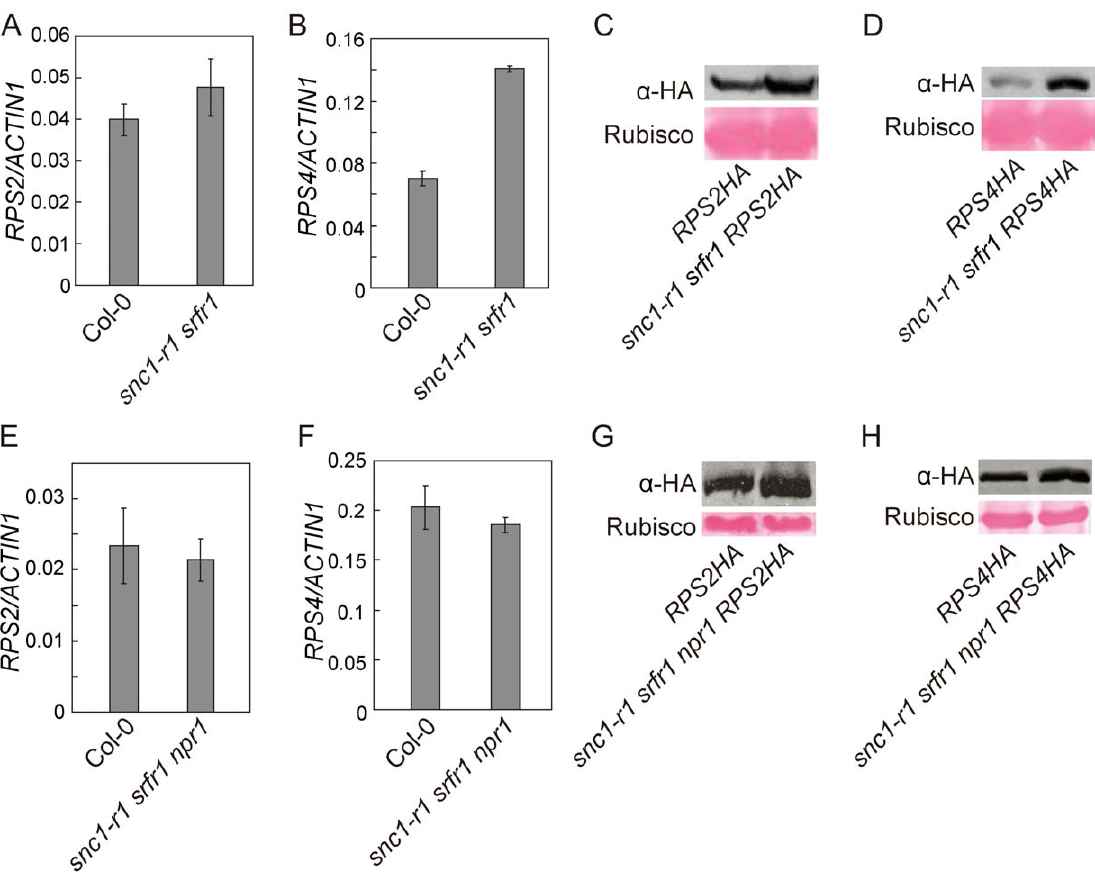
Figure 7. Analysis of the transcript levels of RPS2 and RPS4 and the accumulation of RPS2-HA and RPS4-HA proteins in snc1-r1srfr1-3 and snc1-r1srfr1-3npr1-1 . (A–B) Real-time RT-PCR analysis of RPS2 (A) and RPS4 (B) expression in wild type (Col-0) and snc1-r1 srfr1-3 . Error bars represent standard deviation from three measurements. (C) Western blot analysis of RPS2-HA protein levels in total protein extracts of RPS2-HA and snc1-r1 srfr1-3 RPS2-HA lines. (D) Western blot analysis of RPS4-HA protein levels in total protein extracts of RPS4-HA and snc1-r1 srfr1-3 RPS4-HA lines. (E–F) Real-time RT-PCR analysis of RPS2 (E) and RPS4 (F) expression in wild type (Col-0) and snc1-r1 srfr1-3 npr1-1 . Error bars represent standard deviation from three measurements. (G) Western blot analysis of RPS2-HA protein levels in total protein extracts of RPS2-HA and snc1-r1 srfr1-3 npr1-1 RPS2-HA lines. (H) Western blot analysis of RPS4-HA protein levels in total protein extracts of RPS4-HA and snc1-r1 srfr1-3 npr1-1RPS4-HA lines.